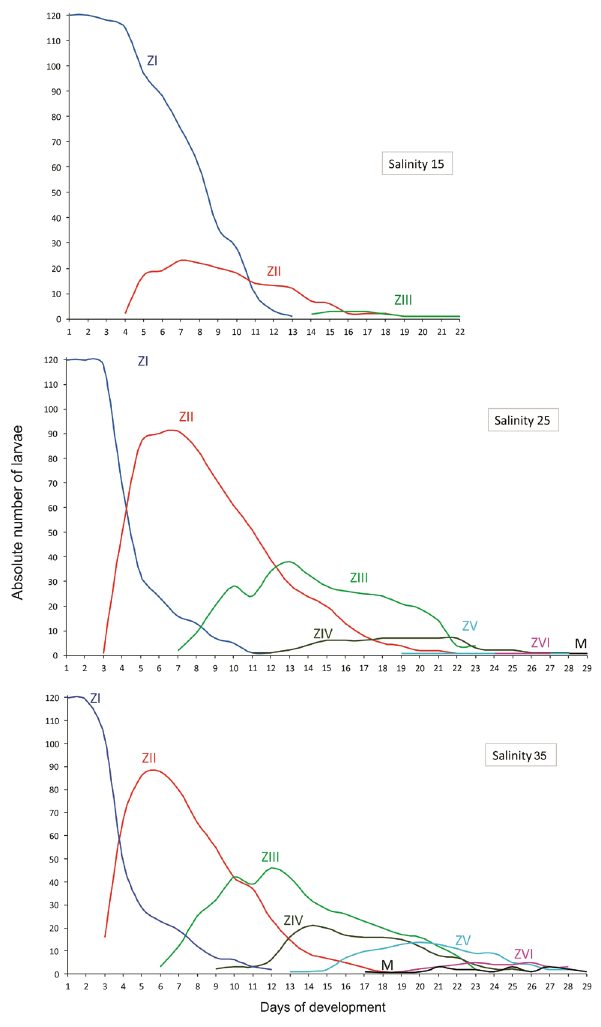
Figure 3. Leptuca leptodactyla . Survival curves (in absolute number) and duration of the zoea stages (in days) of the larvae submitted to treatments S15, S25 and S35.